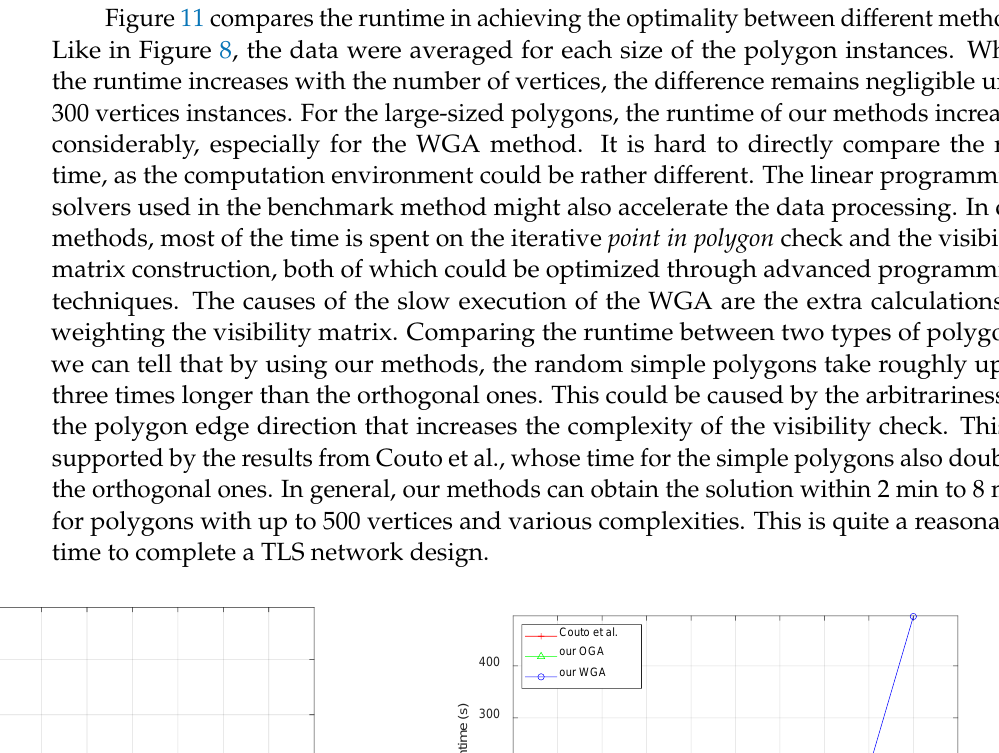
Figure 10. The WGA viewpoint planning results for the sample polygons. ( a ) Random orthogonal polygons with 20 vertices (instance #20-9); ( b ) random orthogonal polygons with 500 vertices (in- stance #500-4); ( c ) random simple polygons with 20 vertices (instance #20-4); ( d ) random simple polygons with 500 vertices (instance #500-29).